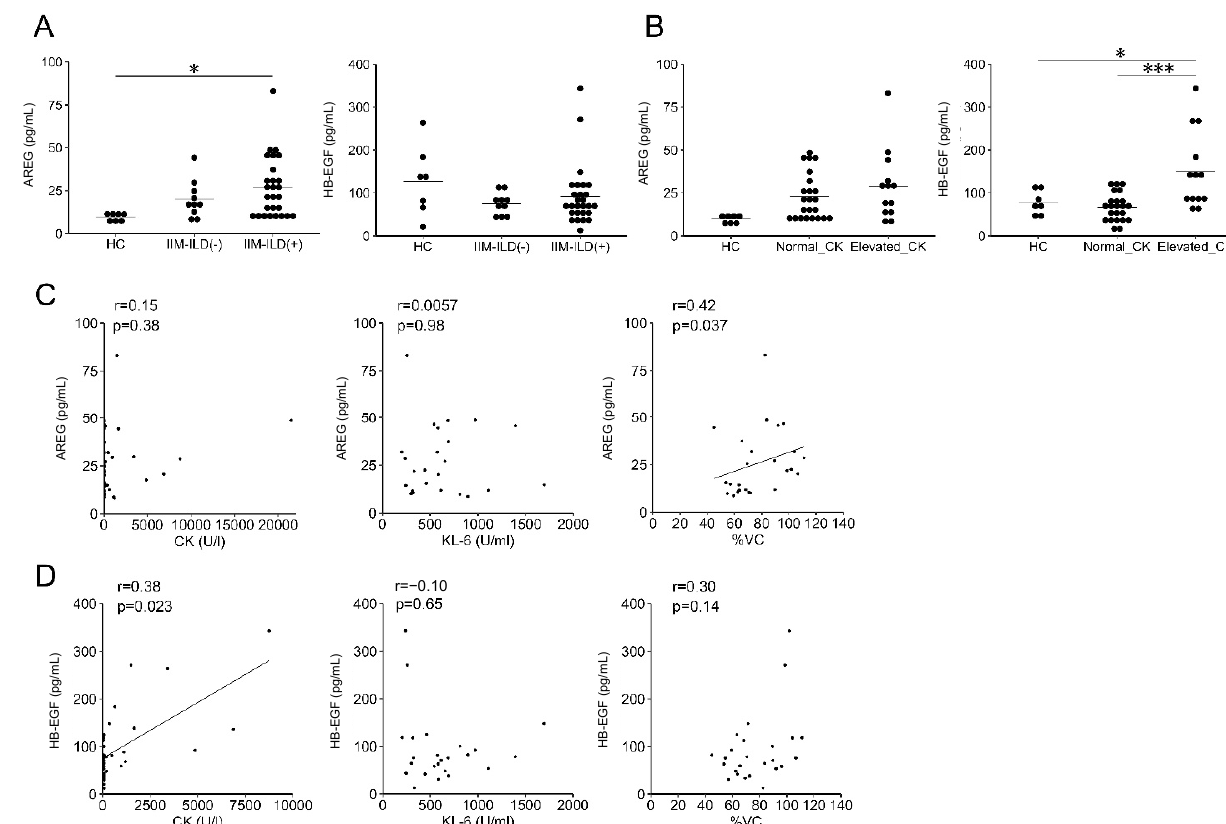
Figure 2. Serum levels of AREG and HB-EGF, and correlation with CK and KL-6 serum levels in patients with IIM. ( A ) Serum AREG (left) and HB-EGF (right) levels in HC and IIM patients with and without ILD. ( B ) Serum AREG (left) and HB-EGF (right) levels in HC, IIM patients with normal CK levels, and IIM patients with elevated CK levels. Elevated CK levels were defined as those exceeding the upper limits of the normal range of CK values (248 U/L and 153 U/L for males and females, respectively). ( C ) Correlation between CK levels and serum AREG in patients with IIM (left), correlation between KL-6/%VC levels and serum AREG in IIM patients with ILD (middle and right). ( D ) Correlation between CK levels and serum HB-EGF in patients with IIM (left), correlation between KL-6/%VC levels and serum HB-EGF in IIM patients with ILD (middle and right). *p <0.05, ***p <0.001. Table 2. Clinical and laboratory parameters in IIM patients with or without elevated serum AREG/HB-EGF levels. AREG HB-EGF